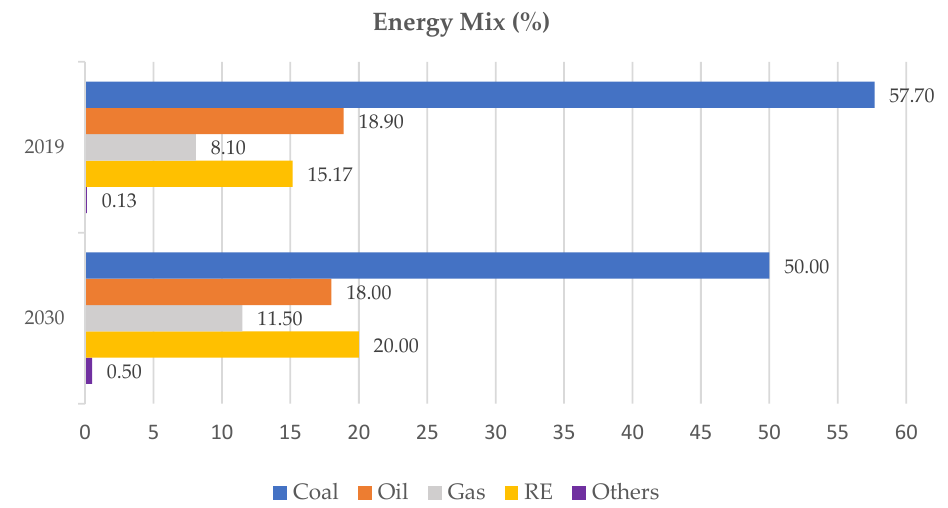
10 of 29 Figure 3. Diagram of China’s Seven Strategic Emerging Industries. Source: Organized by the au- thor and source from [62]. 4.1.2. An Inevitable Measure to Achieve Carbon Peak (PO2) For the past 40 years, conventional fossil fuel energy has accounted for more than 80% of China’s energy mix. Extensive consumption of fossil fuel energy has led to a for- midable conflict between socioeconomic development and environmental pollution as it undermines the living surroundings and threatens the sustainable development of the economy [64]. To coordinate the contradiction between the economy and environment, China has set specific targets to optimize the energy mix. Moreover, China submitted its NDC (National Determined Contribution) under The Paris Agreement in 2016 [65]. By the end of 2019, RE accounted for 15.17% of China’s energy mix, a colossal advancement com- pared with 9.7% in 2012 [59]. Motivated by the aspirational target of carbon peak by 2030, a shift of the current RE proportion from 15.9% (2020) to 20% (2030) is essential. China is now restricting the development of coal power, cautiously developing nuclear power, and encouraging the development of REs including wind power, solar PV power, hydro- power, and biomass power. The overall target for wind power and solar PV power is to reach 1200 GW by 2030. Since solar PV power enjoys the instinctive characteristics of in-